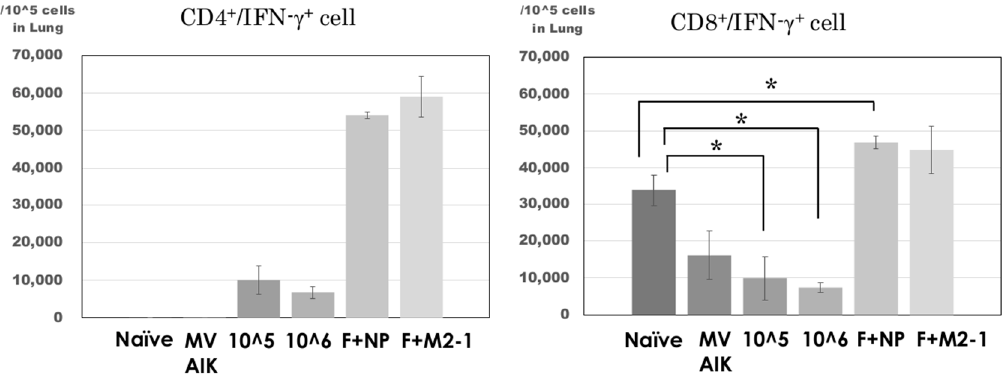
Figure 5. Detection of IFN- γ + expressing cells in lung homogenates. Lung homogenates were obtained after the RSV challenge on Day 88. IFN- γ -producing cells were separated further into CD8 + and CD4 + cells. The bar represents the mean of 3~4 rats per group ± SEM. (* p < 0.05).